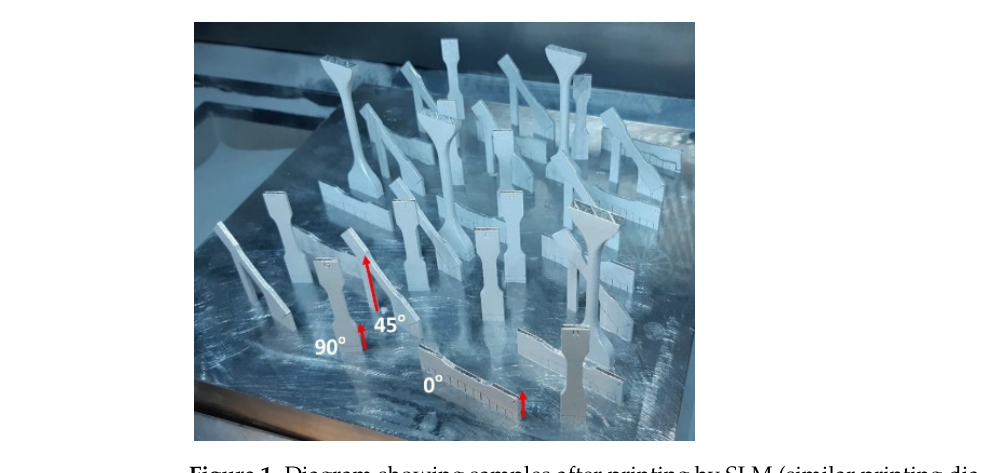
Figure 1. Diagram showing samples after printing by SLM (similar printing diagram was reported for EBM). Note: build orientation is shown by the red arrows.